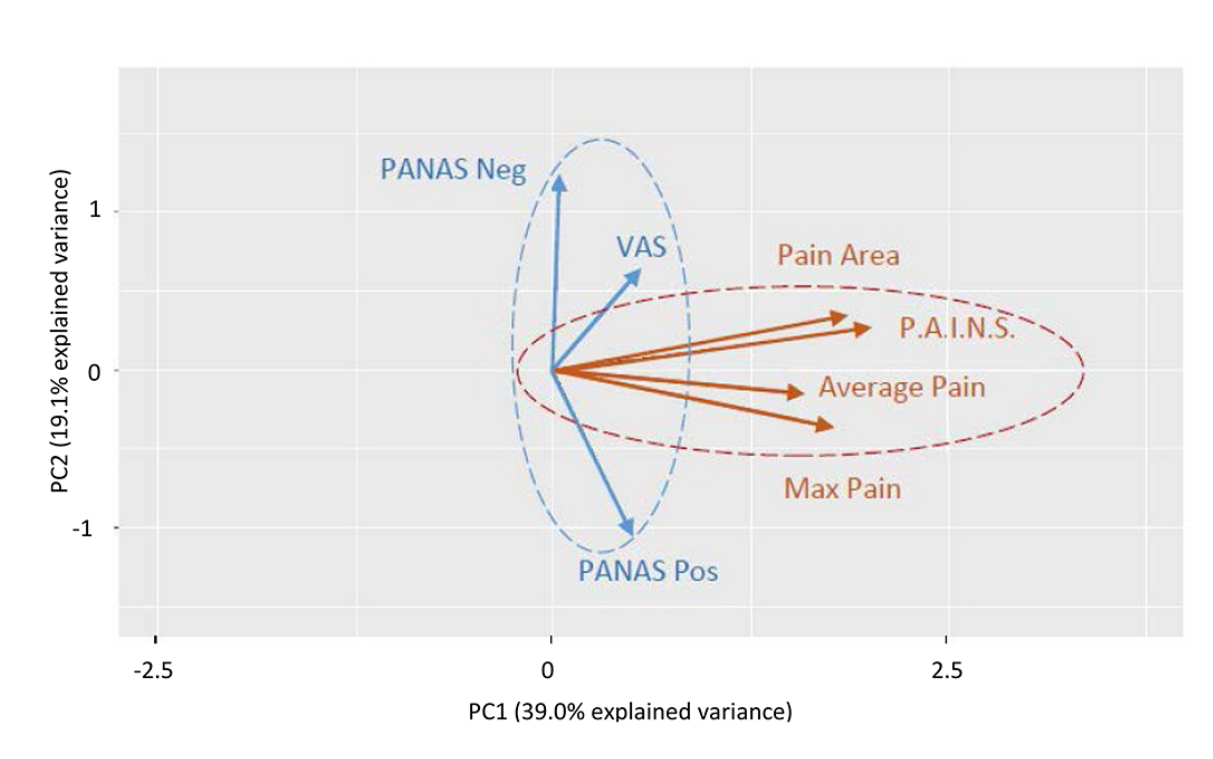
Figure 2. PCA graph showing the most representative correlation among the measures at the baseline visit. PAINS: pain area and intensity number summation; PANAS: positive and negative affect schedule; PCA: principal component analysis; PC1: first principal component; PC2: second principal component; VAS: visual analog